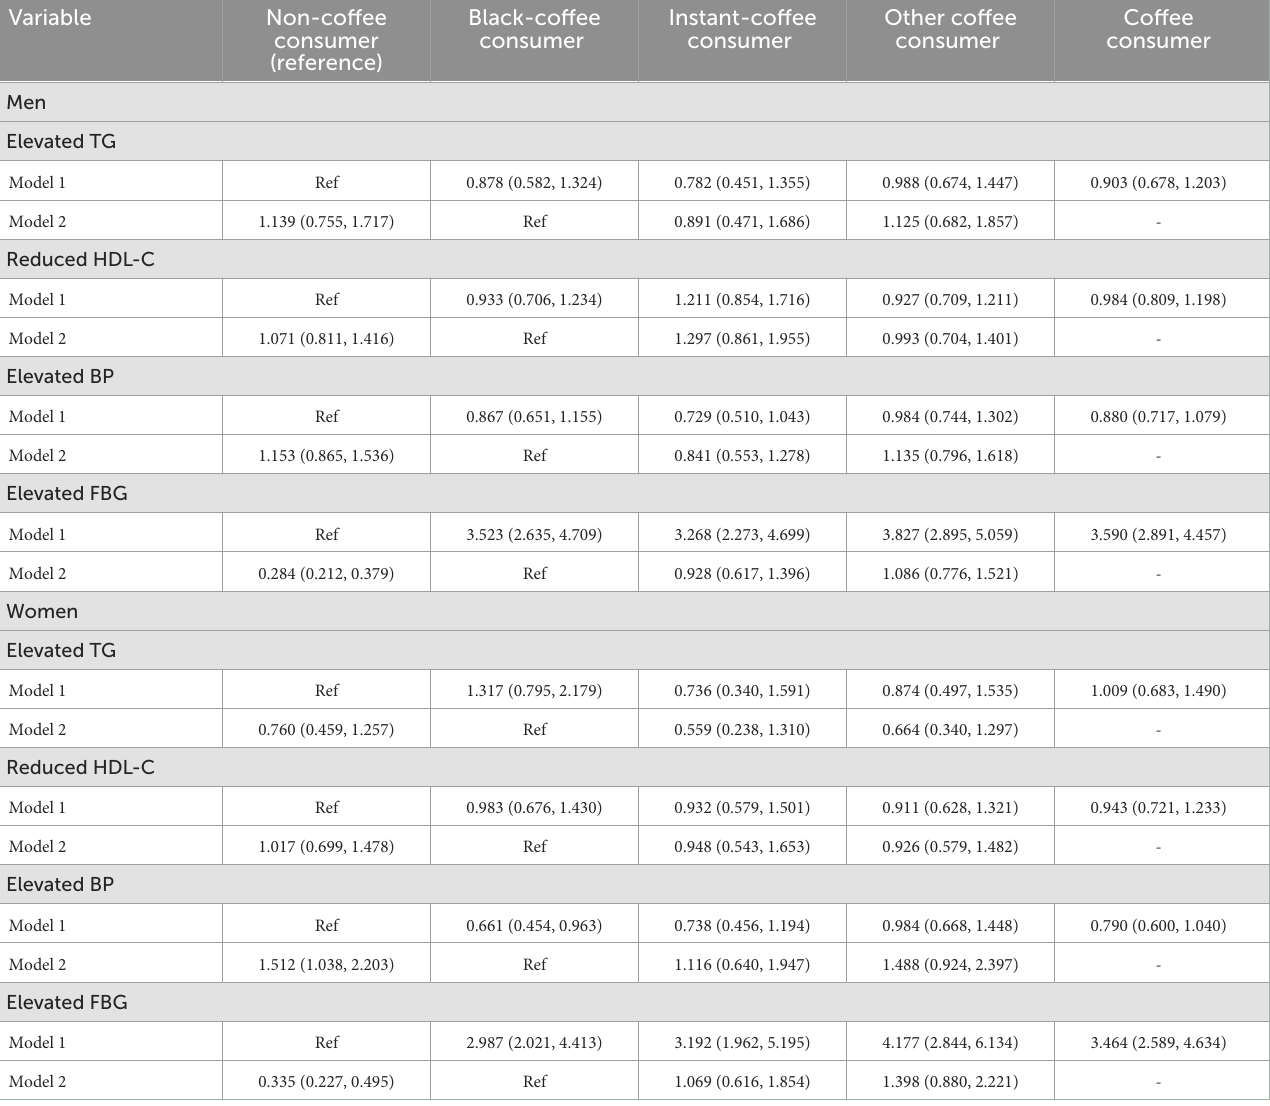
TABLE 2 Multivariable-adjusted odds ratios and 95% CIs for metabolic components according to the type of coffee consumed (by